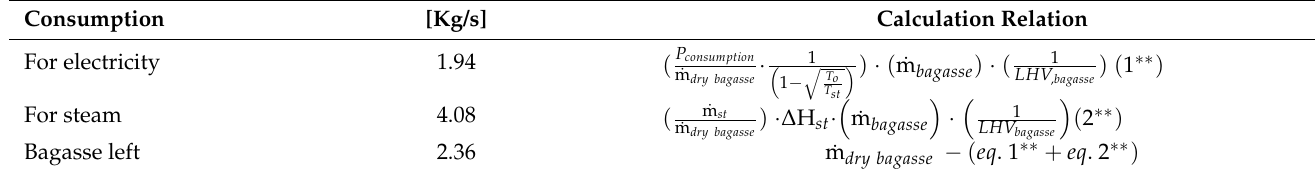
Table A5. Dry bagasse consumption to electricity generation and steam production (8.4 kg/s), as well as bagasse left for biofuel